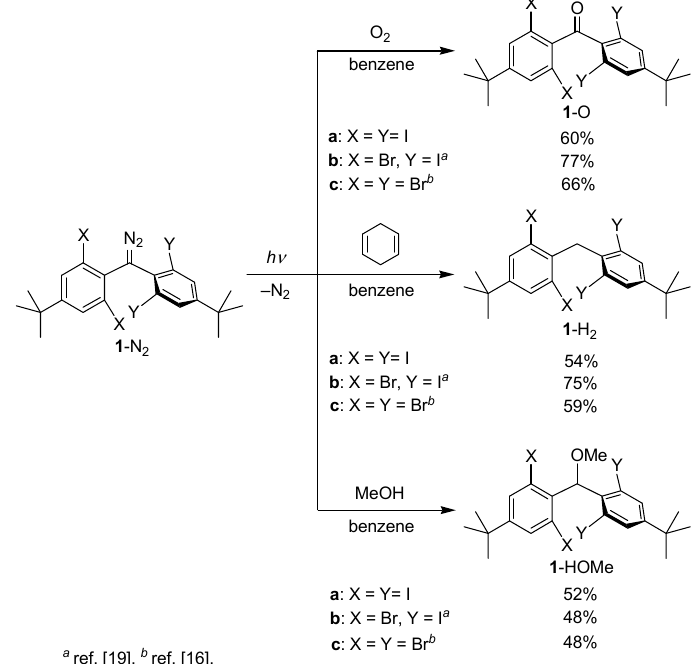
Scheme 6. Photoproducts obtained by irradiation of diazo compound 1 -N 2 at 25 ◦ C.